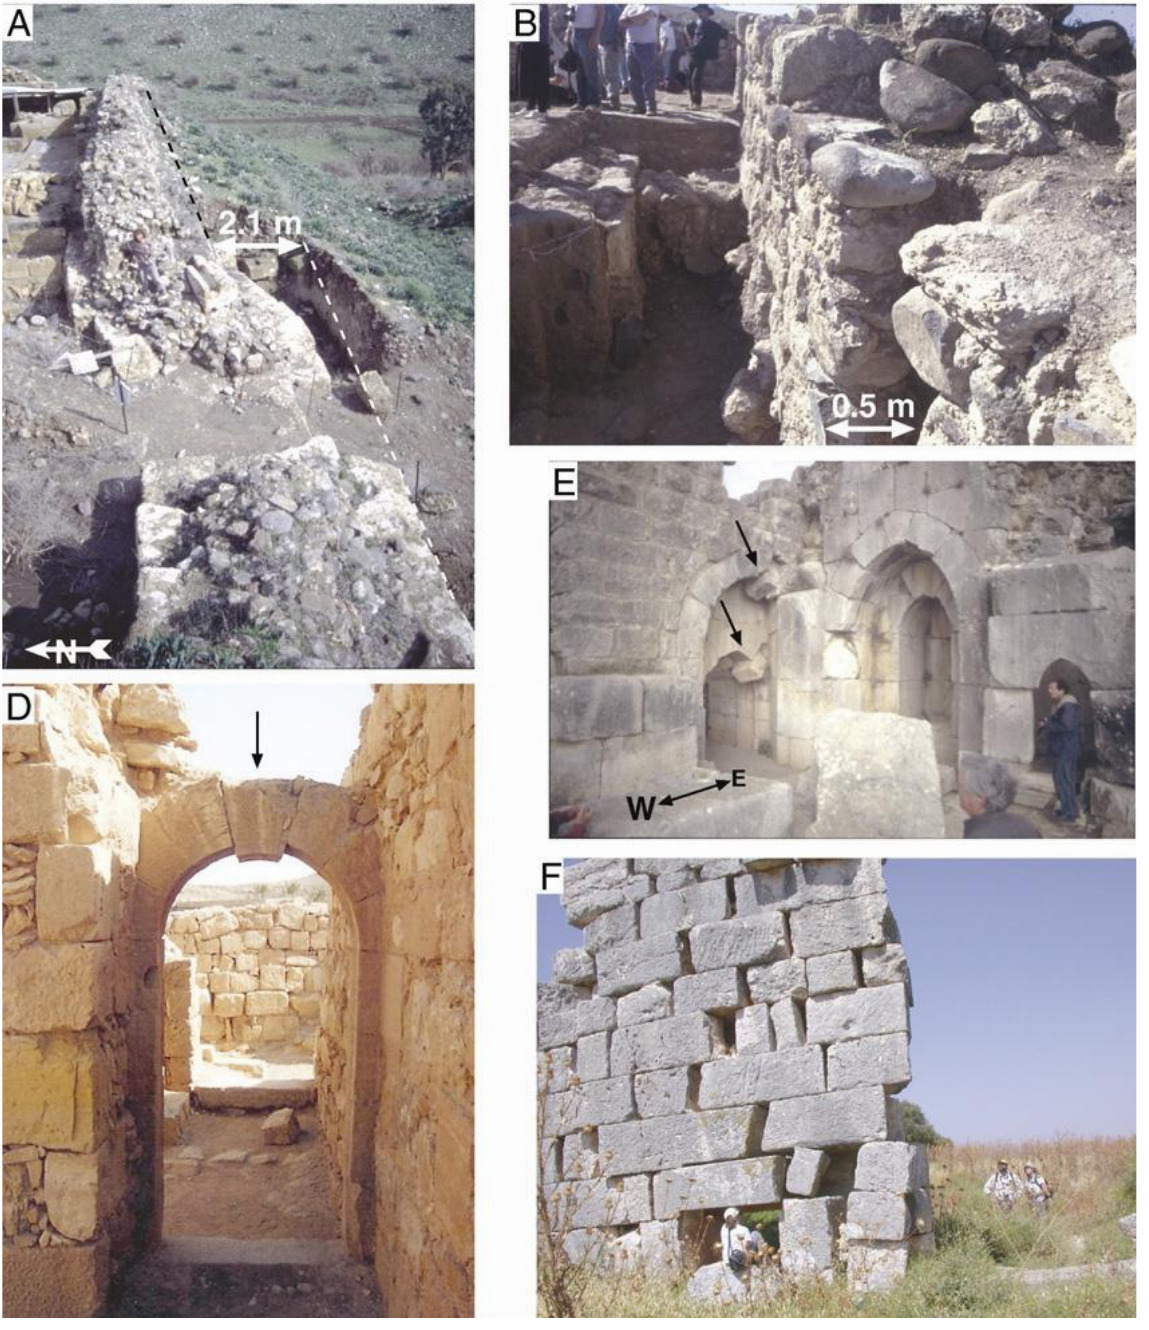
Fig. 4. (A) An offset wall of the Crusader fortress of Vadum Iacob. Dashed line shows original geometry. The 2.1-m-offset is the sum of 1.6m and 0.5m displacement caused by the earthquakes of 20 May 1202 and 30 October 1759, respectively. (B) . An offset wall of the Ottoman Mosque that is built on top of the Crusader fortress of Vadum Iacob. The associated earthquake occurred on October 30, 1759 (C) . A water trough in Um el Kanatir left-laterally offset about 1m on the margin of a landslide triggered by the earthquake of 18January 749 (D) . A keystone slid down in an arch enclosed symmetrically by a wall (photographed in Mampsis) (E) . Blocks on the sides of arches on the left slid down in the earthquake of 1759 in Kal’at Nimrod. Throughout the site, arches in walls that trend E–W are deformed whereas similar arches in N–S trending walls have remained intact (F) . Horizontal shift of large ashlars in the Hellenistic temple of Kadesh (site occurred in the 749 earthquake). All these sites occur in Northern Israel (after Marko,